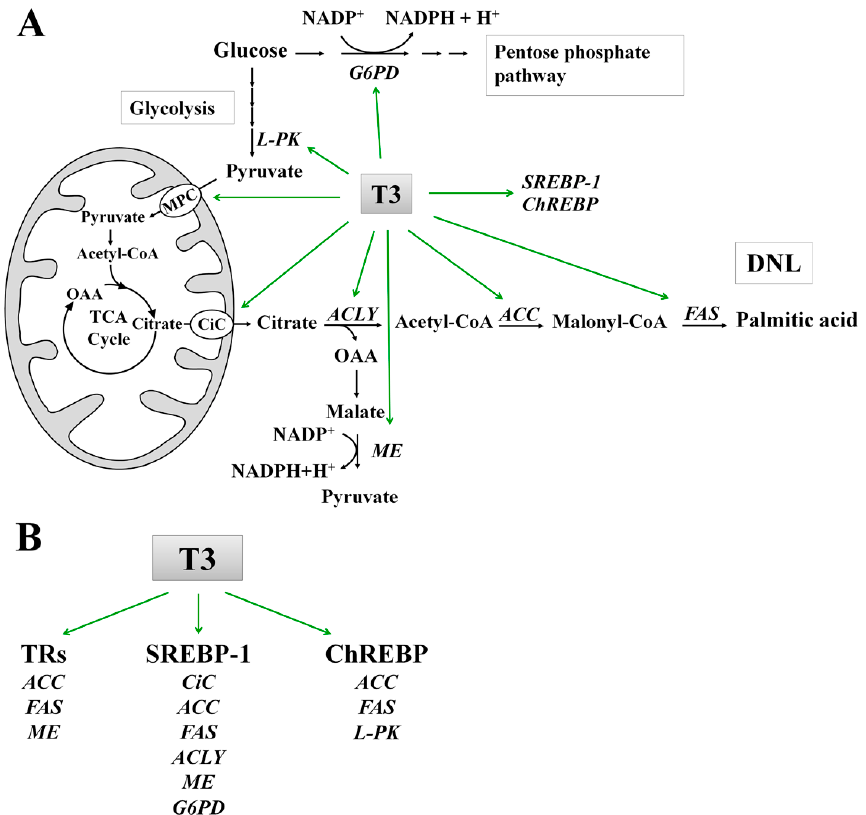
Figure 1. ( A ) Schematic representation of the role of T3 in the stimulation of activity and expression of enzymes, mitochondrial carriers, and transcription factors involved in the synthesis of palmitic acid from glucose; and ( B ) Effects of T3 on the activation of fatty acid synthesis through thyroid receptors (TRs) and lipogenic transcription factors (SREBP-1 and ChREBP). Abbreviations: ACC, Acetyl-CoA carboxylase; ACLY, ATP-citrate lyase; ChREBP, Carbohydrate Response Element Binding Protein; CiC, Citrate carrier; DNL, De novo lipogenesis; FAS, Fatty acid synthase; G6PD, Glucose-6-phosphate dehydrogenase; L-PK, Liver pyruvate kinase; MPC, Mitochondrial pyruvate carrier; ME, Malic enzyme; OAA; oxalacetic acid; SREBP-1, Sterol regulatory element-binding protein 1; TCA, Tricarboxylic acid